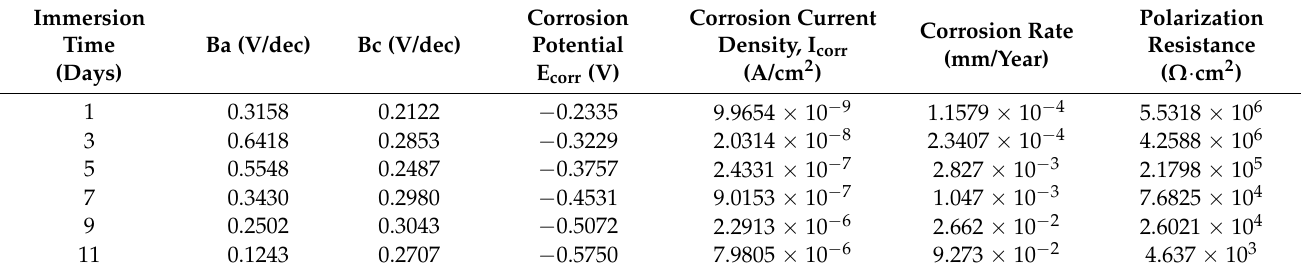
Figure 8. Tafel spectrum of CPEEUA/FS conducted in 3.5 wt% NaCl solution (corrosive medium) as a function of exposure times. Table 1. Tafel parameters of CPEEUA/FS-40